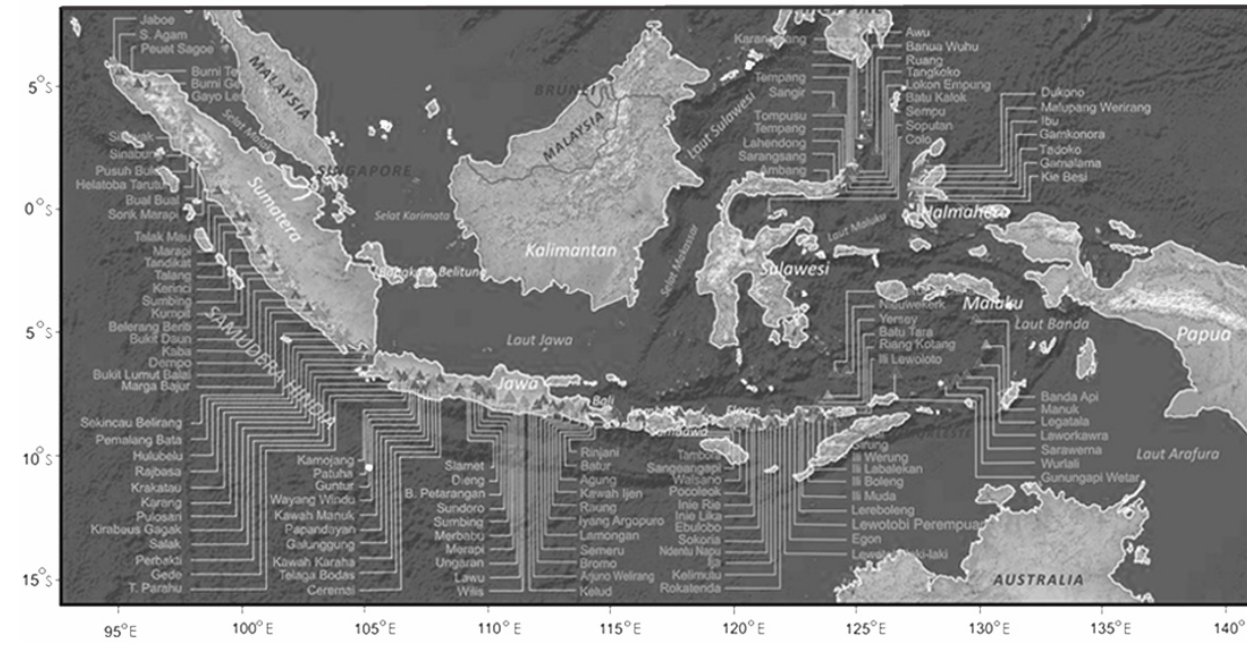
Figure 1. Distribution of active volcanoes in Indonesia (Surono,